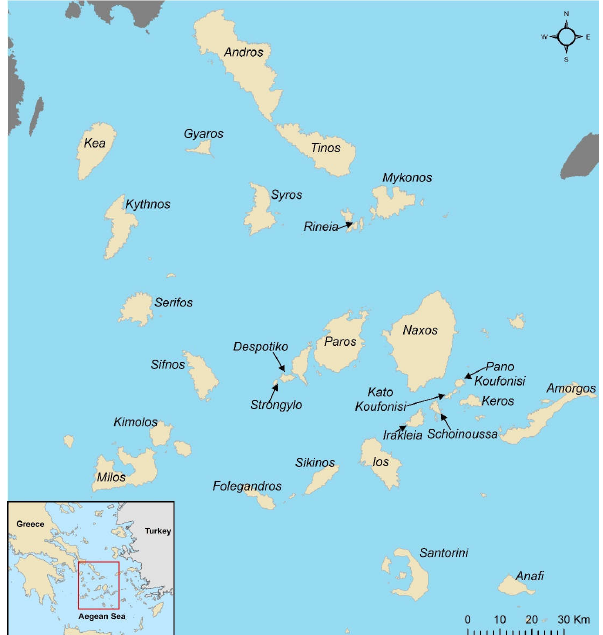
Figure 1. The study area of the Cyclades in the Aegean Sea.